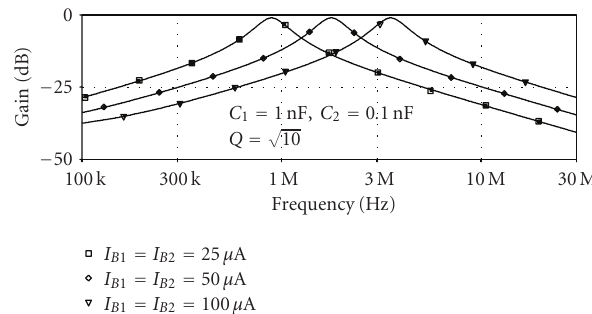
Figure 8: Current-mode bandpass responses for di ff erent values of I B 1 and I B 2 with keeping their ratios